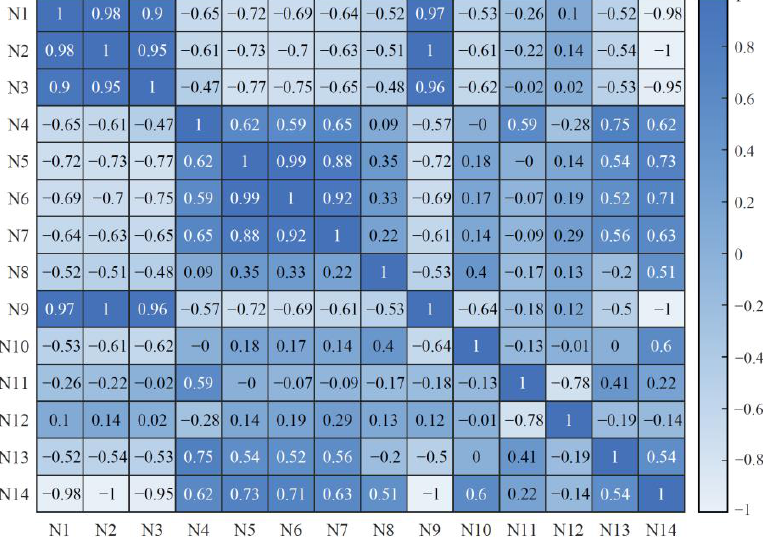
Figure 3. Heatmap of the variable correlations in the spatial dimension.